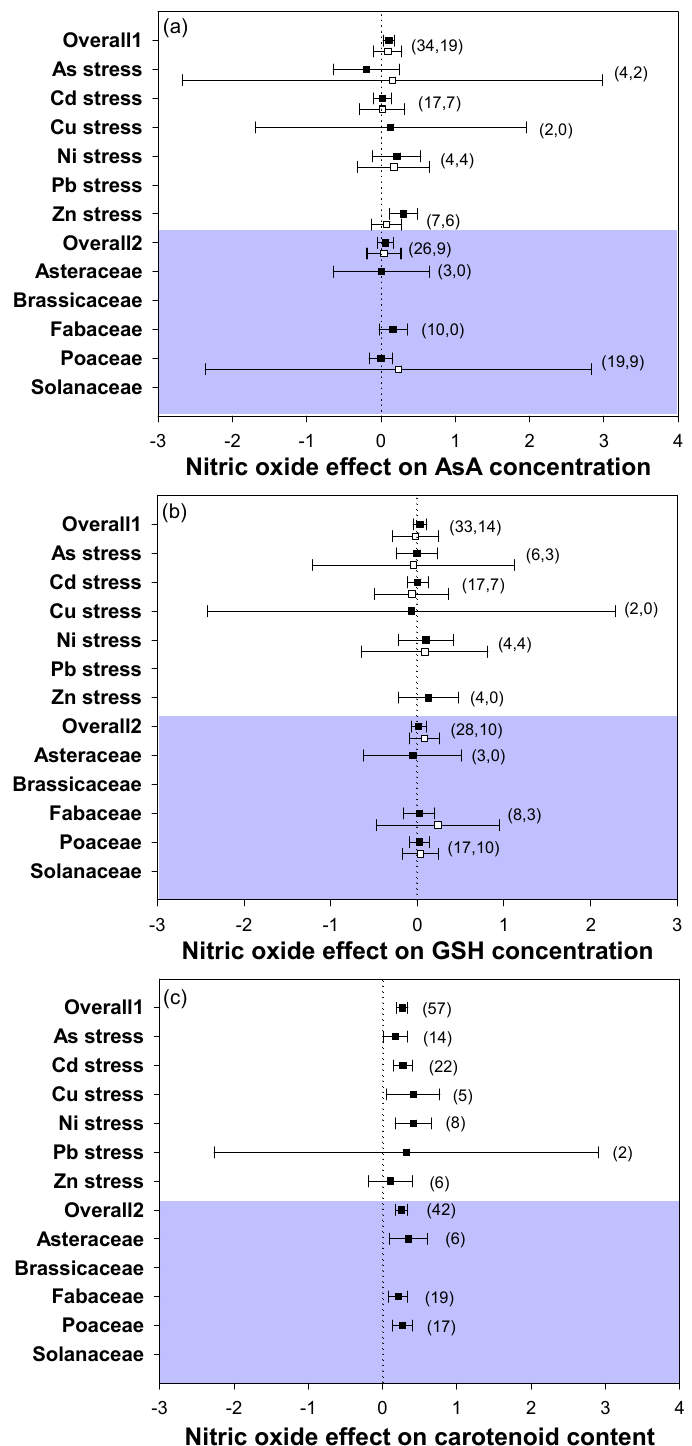
Figure 4. Plots of effect sizes for the effect of NO on antioxidant contents of heavy metal-stressed plants, including ( a ) AsA concentration, ( b ) GSH concentration, and ( c ) carotenoid content. Overall1 and overall2 indicate the mean (summary) effect size of all metal stresses and plant families, respectively. Black and white dots indicate the mean effect sizes for factor groups of leaf and root responses, respectively. The numbers in brackets specify the number of data points. The black square block with the error bar indicates the mean response size with a 95% confidence interval, and the dashed vertical line shows zero effect.